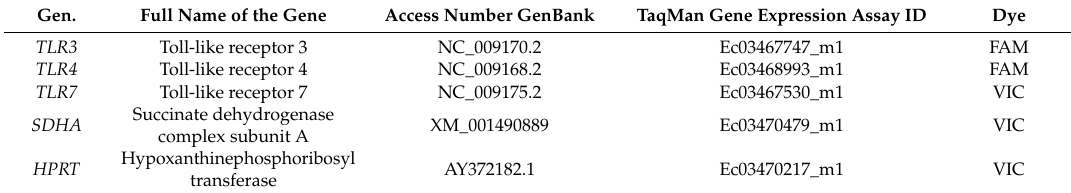
Table 1. Probes used for amplification of Toll-like receptor (TLR) genes and housekeeping